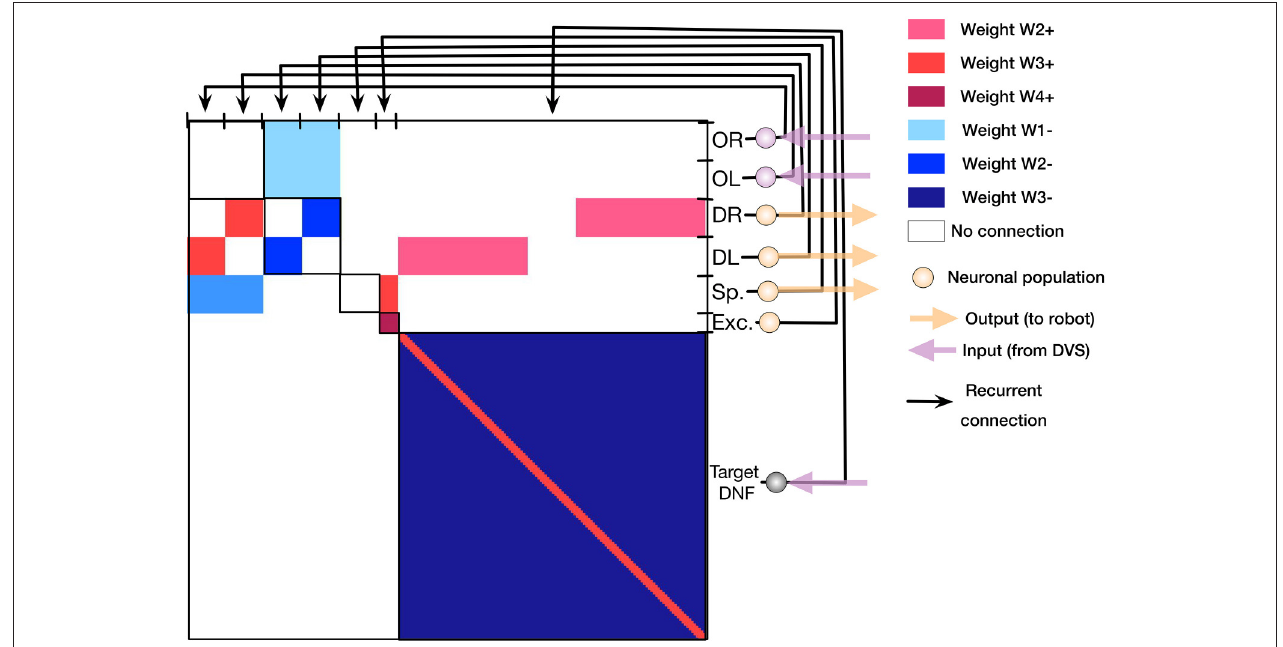
FIGURE 5 | The synaptic connectivity matrix, configured on the ROLLS chip to implement the obstacle avoidance and target acquisition architectures. Colors encode different synaptic weights (red for positive and blue for negative connection weights) of the recurrent connections on the chip.